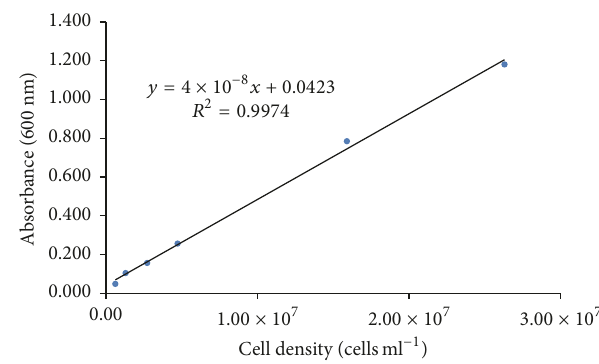
Figure 1: The standard curve of optical density- Nannochloropsis